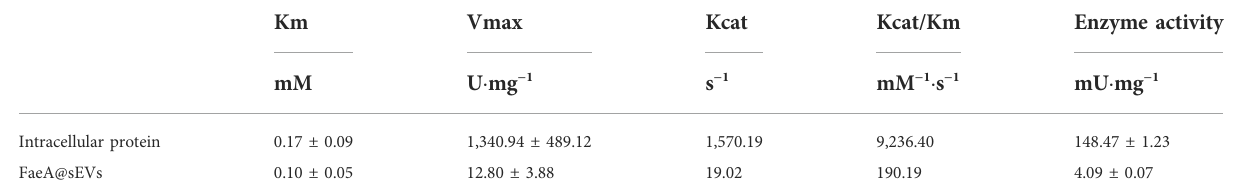
TABLE 1 Kinetic parameters of FaeA in different